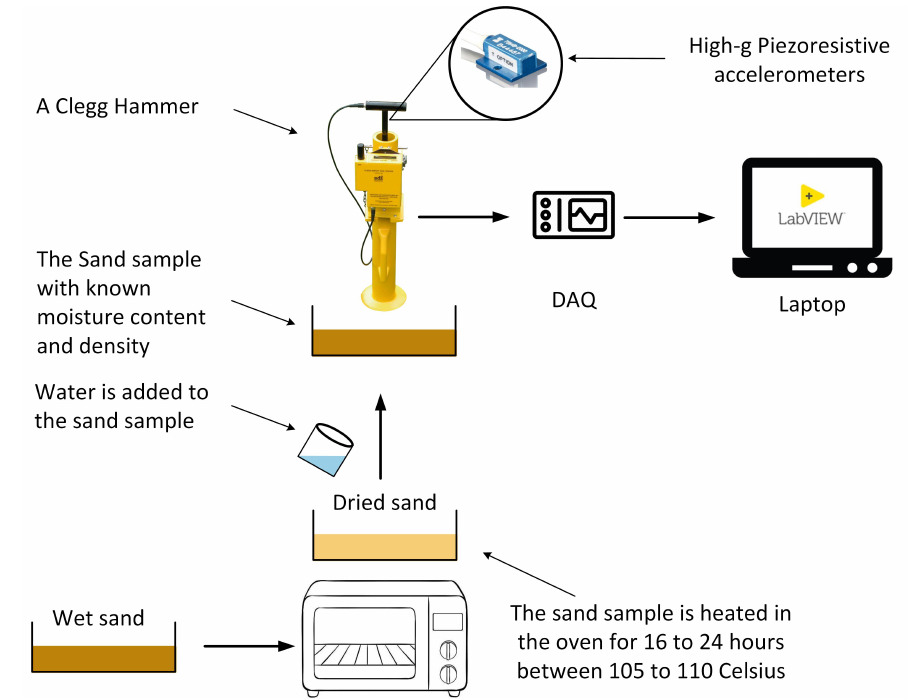
Figure 4. The process of drying the sand sample, altering the moisture content and impact testing using a modified Clegg